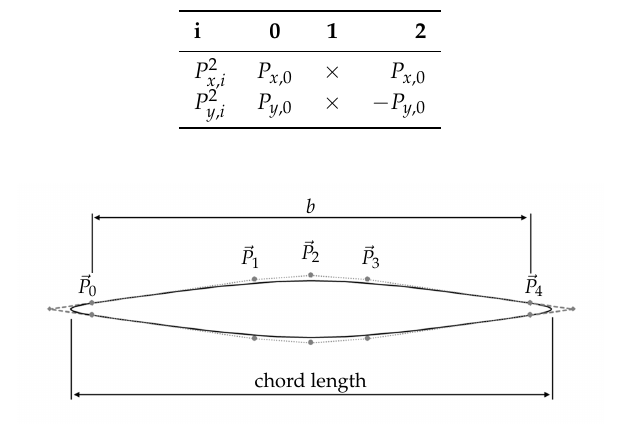
Figure 10. Parameterized blade with Bézierspline control points.